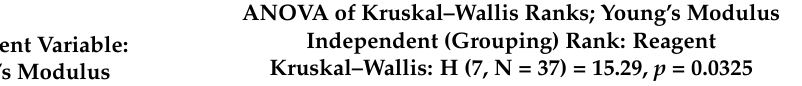
Table 6. Results of the Kruskal–Wallis test.